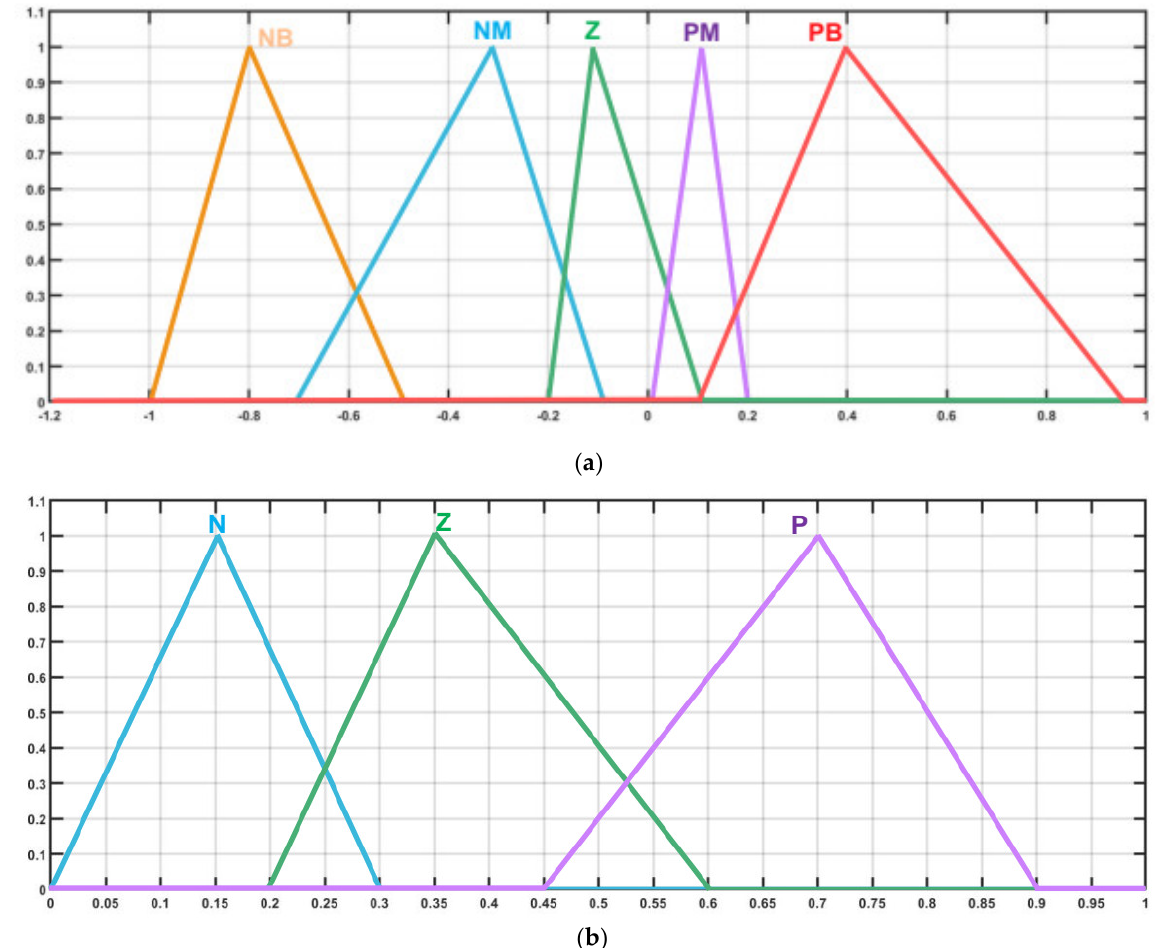
Figure 6. Fuzzy controller input membership function: ( a ) ΔV and ( b ) delay. Table 2. Membership functions of input and